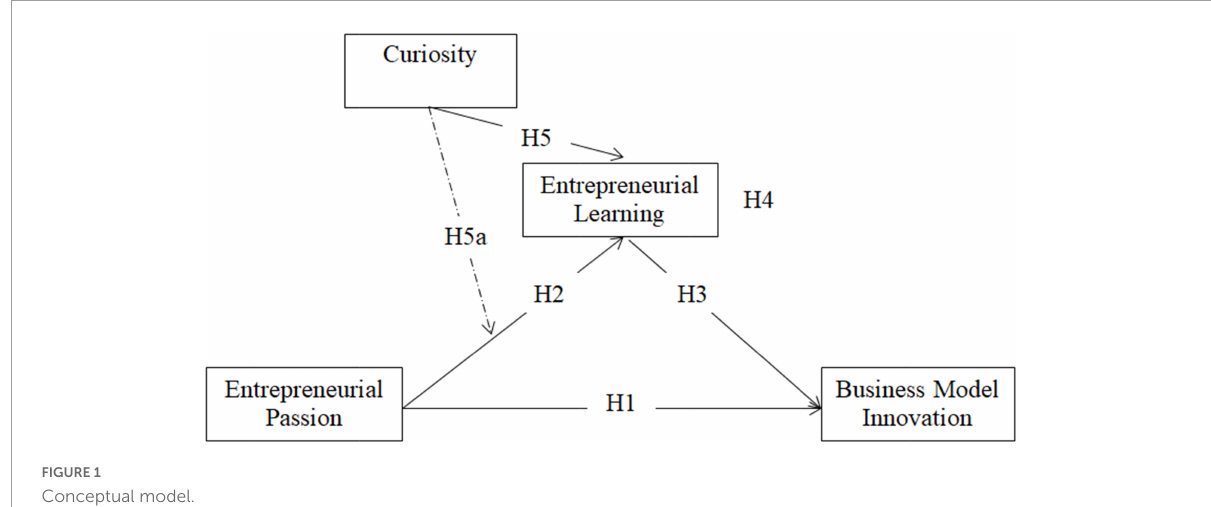
FIGURE1 Conceptual